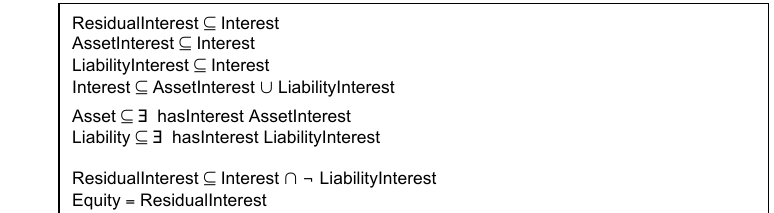
Equity defined through interest